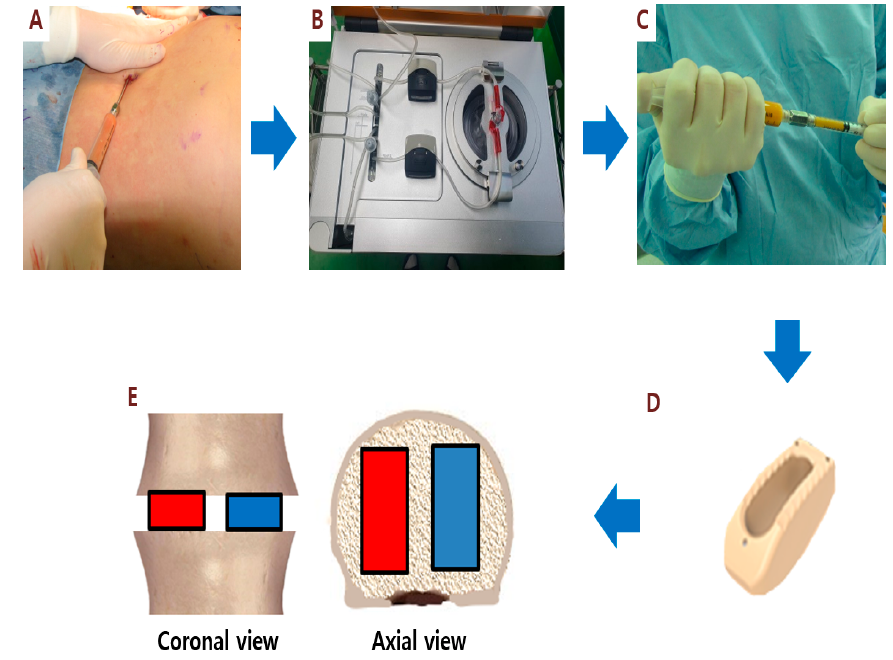
Figure 1. Stromal vascular fraction (SVF) isolation and injection. Step 1: Adipose tissue is harvested by manual liposuction ( A ). The Cellunit ® System ( B ) generates adipose-derived SVF ( C ) from adipose tissue collected manually. For posterior lumbar interbody fusion, the polyetheretherketone (PEEK) cage without lateral side holes ( D ) was used. The PEEK cage on the right side (red color) of the patient is packed with SVF and β -tricalcium phosphate ( β -TCP) mixture and the cage on the left side (blue color) is packed with SVF alone( E ).